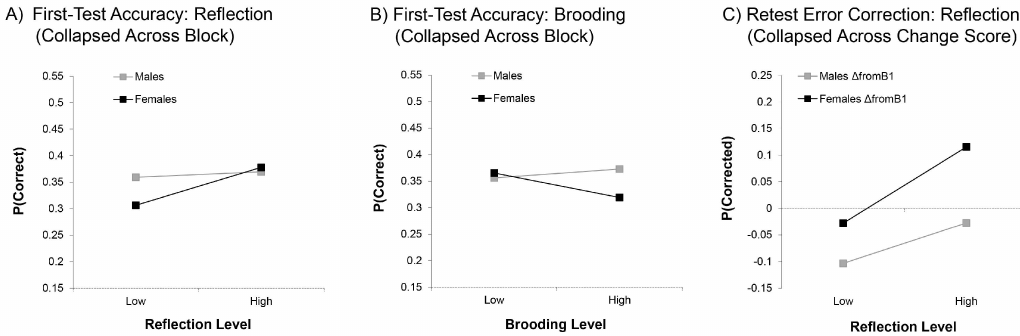
Figure 2. Memory performance as a function of RRS and gender. Effects of Reflection ( A ) and Brooding ( B ) on the proportion of first-test questions answered correctly across all blocks; ( C ) Effects of Reflection on change in error correction between Block 1 and subsequent